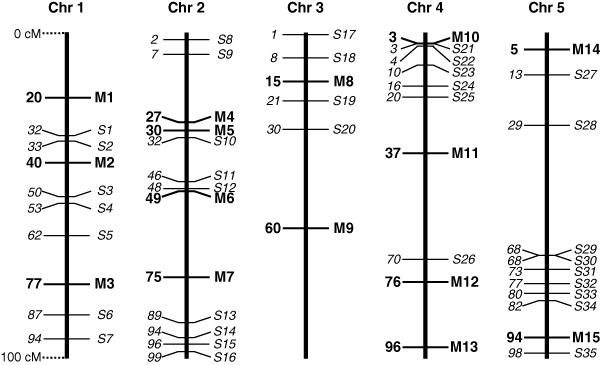
Chromosomal positions of simulated QTL. Each simulated chromosome (Chr) is 100 cM long. QTL are indicated on the right-hand side of each chromosome and their position in cM on the left-hand side. No QTL were simulated on chromosome 6.